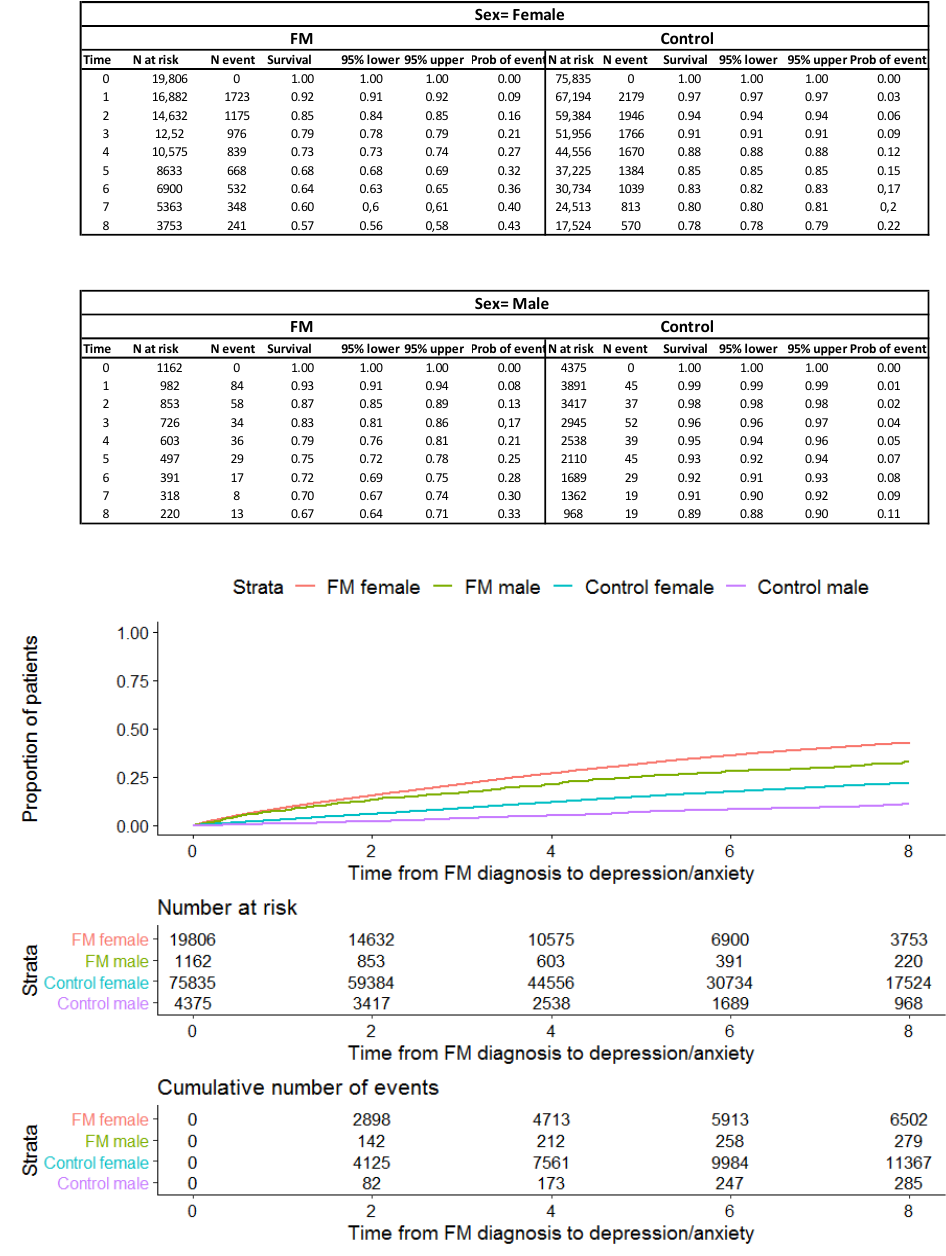
Figure 2. Kaplan – Meier survival curve at eight years for the outcome according to sex. Figure 2. Kaplan–Meier survival curve at eight years for the outcome according to (Table 3) The Cox model of time to onset of anxiety and/or depression with the vari- ables group, sex, age and MedeA. Table 3. Cox model of time to onset of anxiety and/or depression with the variables group, sex, age and MedeA.